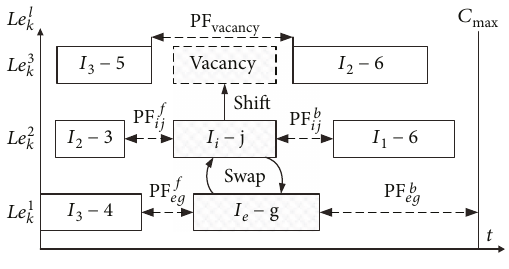
Figure 5: Robust equipment